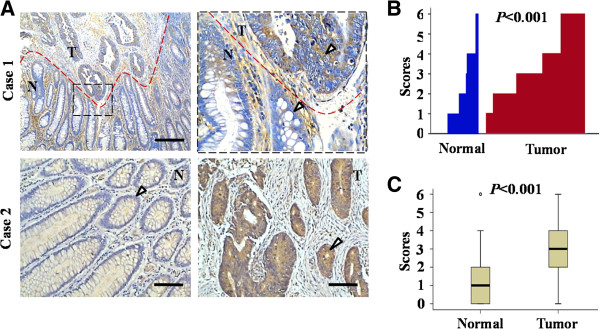
A, CXCL14 expression was elevated in human colorectal cancer. Individual FFPE sections (e.g. case 1) demonstrated normal colorectal mucosa, with adjacent colorectal cancer that had invaded underneath the normal mucosa. Inset in the left panel, the junction between normal mucosa and adjacent tumor, shown at a higher magnification in the right panel, demonstrated the differences in the level of CXCL14 expression. ‘T’ refers to tumor tissue and ‘N’ refers to adjacent non-tumor tissue from the same patient. Bar, 100 μm. Paired samples of normal colorectal tissue and colorectal tumor tissue from the same patients (e.g. case 2) demonstrated little detectable CXCL14 immunoreactivity in the normal colorectal mucosa. In contrast, the colorectal tumor demonstrated intense CXCL14 immunostaining in the cytoplasm of the tumor. Bar, 50 μm. B, CXCL14 expression was plotted using the immunohistochemical scores in each carcinoma and adjacent normal tissues. C, CXCL14 expression scores were shown as box plots, with the horizontal lines representing the median; the bottom and top of the boxes representing the 25th and 75th percentiles, respectively; and the vertical bars representing the range of data.